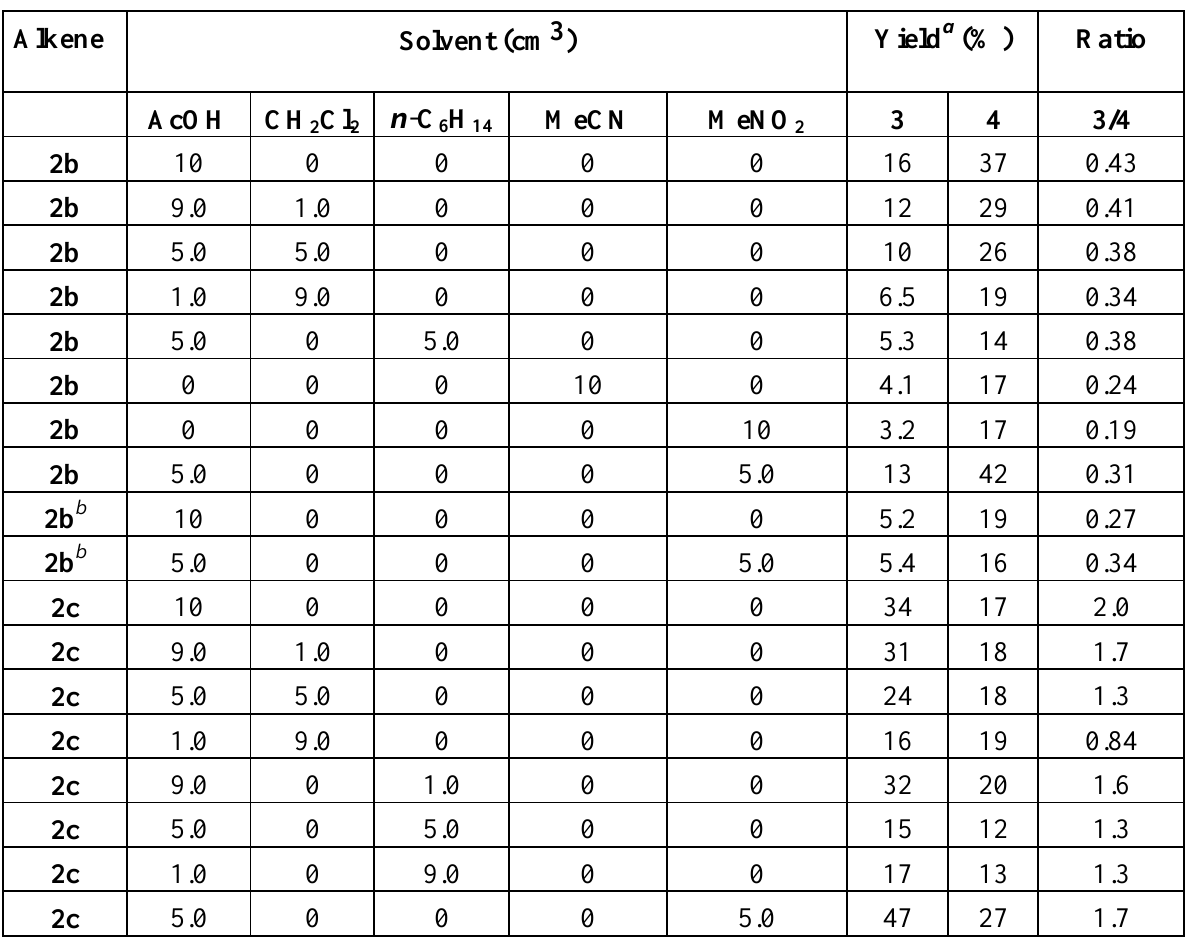
(0.68 mmol) at 25 ° 2